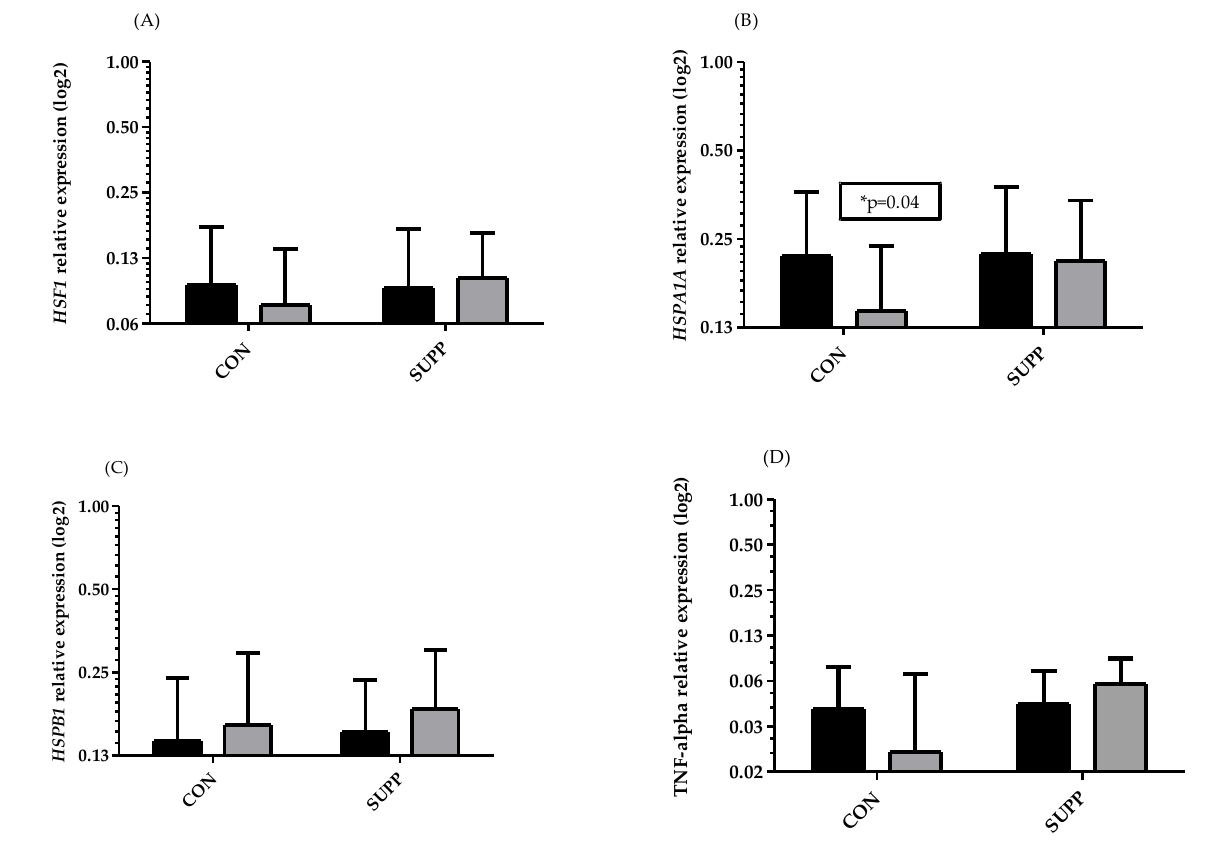
Figure 2. Changes in HSF-1 ( A ), HSPA1A ( B ), HSPB1 ( C ), and TNF-a ( D ) relative expression before (dark bars) and after 6 weeks (gray bars) in the CON group and SUPP group. All data are presented as log 2. * Significant differences between pre/post values ( p < 0.05).